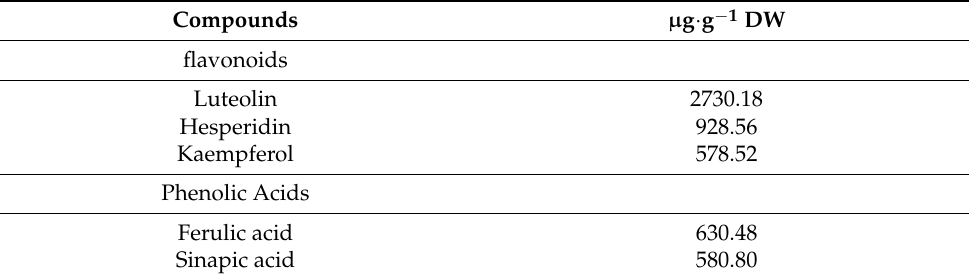
Figure 3. Flowers of Haberlea rhodopensis. 3.2. The EVOdrop Turbine Water Purifier Т he proprietary operating principle and developed geometry of the EVOdrop tur- bine (Figures 4) allow for highly efficient treatment. Incoming water passes through the rotating turbine, driving it with its pressure, which in turn makes water pass through the rotating device. Specific outcomes of this treatment are based on magnetohydrodynamic forces [4,5]. Figure 4 shows EVOdrop’s turbine operation principle.